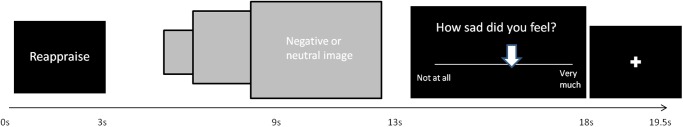
Events comprising each trial.